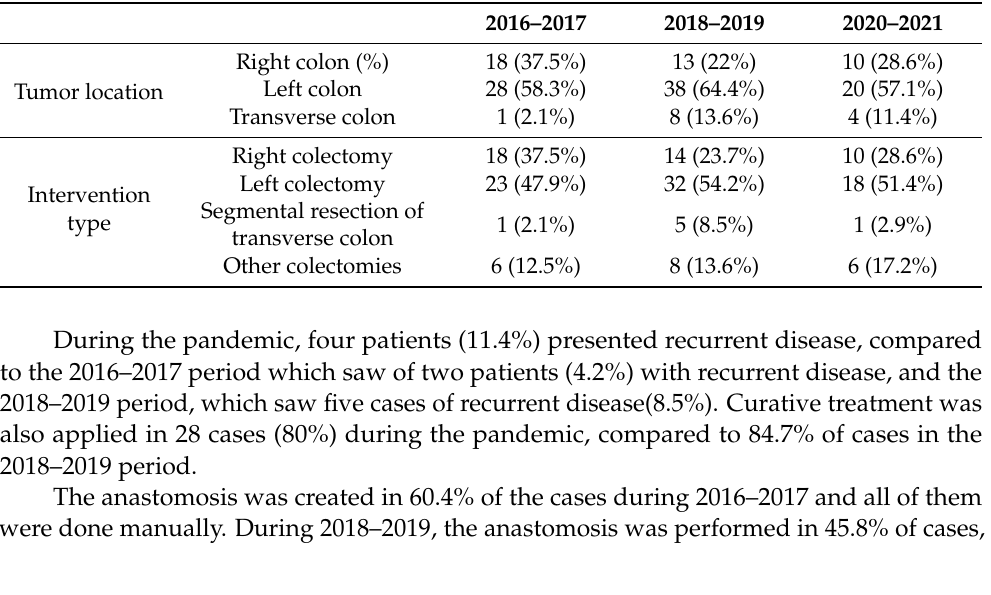
Table 2. Tumor location and type of surgery